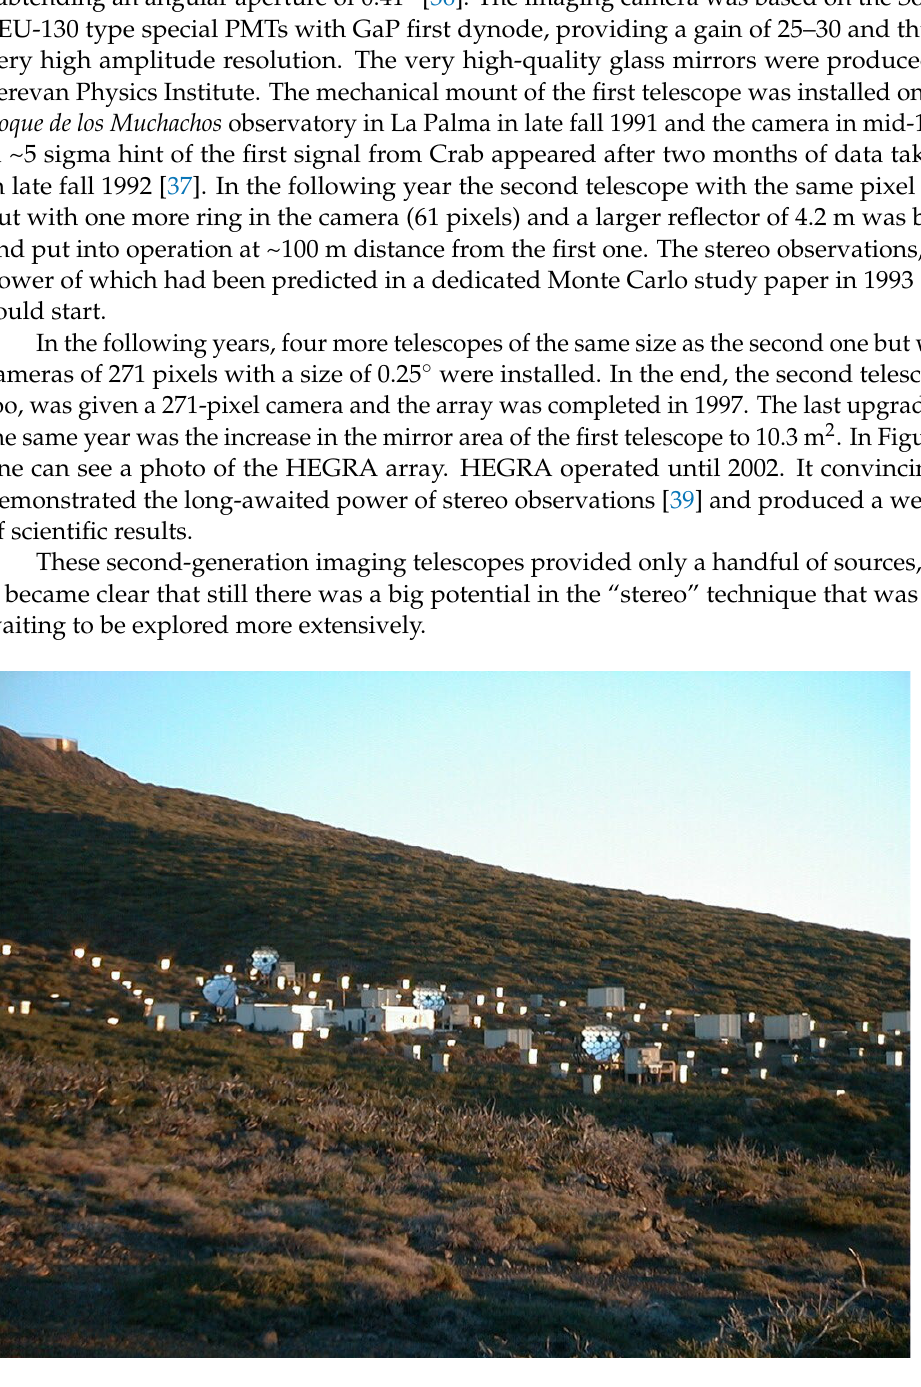
Figure 5. Photo of the HEGRA array. One can see four out of the six IACTs of HEGRA.